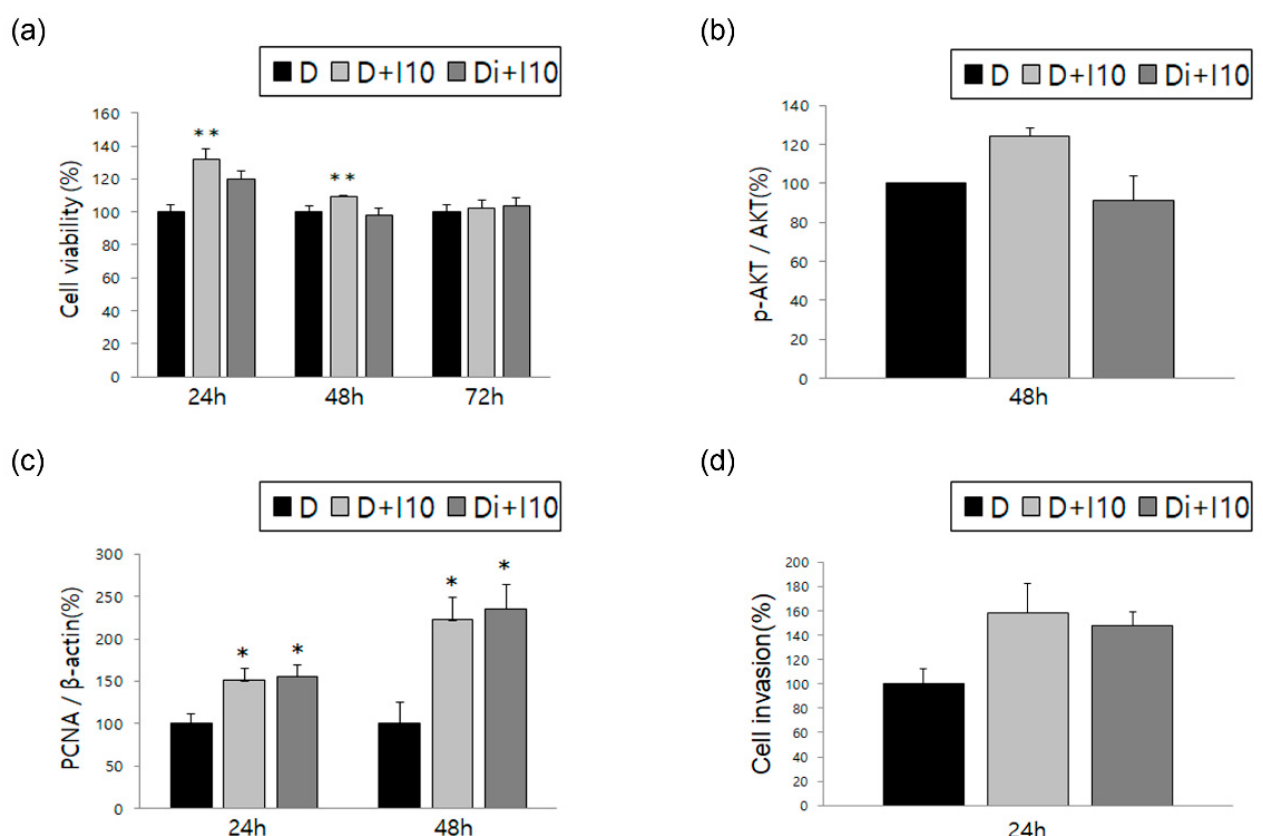
Figure 3. Effect of DNG with interleukin (IL)-1 β on human ESCs. The graphs show time-dependent variation evaluated in the three groups for the following factors: ( a ) cell viability, ( b ) AKT phosphorylation, ( c ) PCNA expression, and ( d ) cell invasion. Error bars show the mean ± SEM. * p < 0.05 versus control, ** p < 0.05 versus control as well as treatment with both DNG and IL-1 β in ESCs. D = ESCs in DMSO solution (control); D + I10 = treated with IL-1 β 10 ng/mL; Di + I10 = treated with DNG 10 − 6 M and IL-1 β 10 ng/mL. Data are expressed as a percentage, wherein cells treated with the vehicle are normalized to 100%.